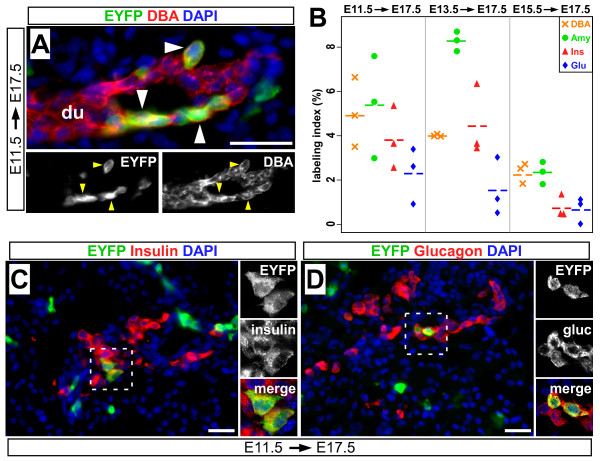
Muc1+ cells give rise to endocrine cells during embryogenesis. (A) A single dose of 5 mg tamoxifen was given to pregnant mice at E11.5, and pancreata of Muc1IC2/IC2; Rosa26EYFP/+ offspring were analyzed at E17.5 by immunofluorescence for EYFP (green), DBA lectin (red) and DAPI (blue). Arrowheads indicate DBA+ cells co-expressing EYFP. (B) Quantification of observed co-labeling at E17.5, following tamoxifen administration at indicated time points. Scatter plot depicts the percentages of DBA+ (orange), amylase+ (green), insulin+ (red) and glucagon+ (blue) cells co-expressing EYFP. Each point represents an independent embryo, and means are indicated by dotted lines. (C-D) Pancreata of Muc1IC2/IC2; Rosa26EYFP/+ embryos, administered TM at E11.5 as in (A), stained at E17.5 for EYFP (green), insulin or glucagon (red) and DAPI (blue). Inserts: confocal z-projection (1.36 μm) of the boxed areas, to confirm localization of EYFP to hormone-producing cells. Scale bars: 25 μm.